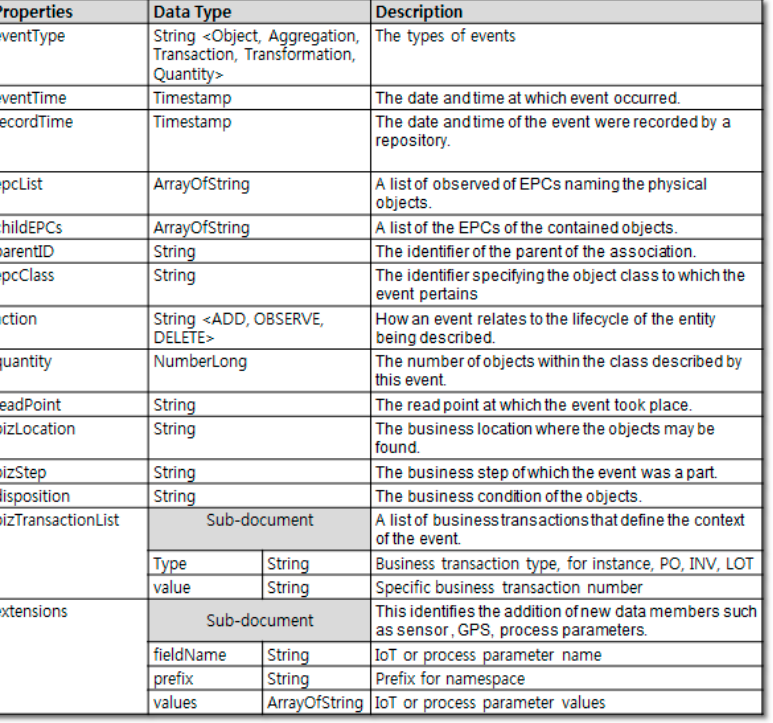
Figure 3. Traceability event data model and example (summarized from [13]).